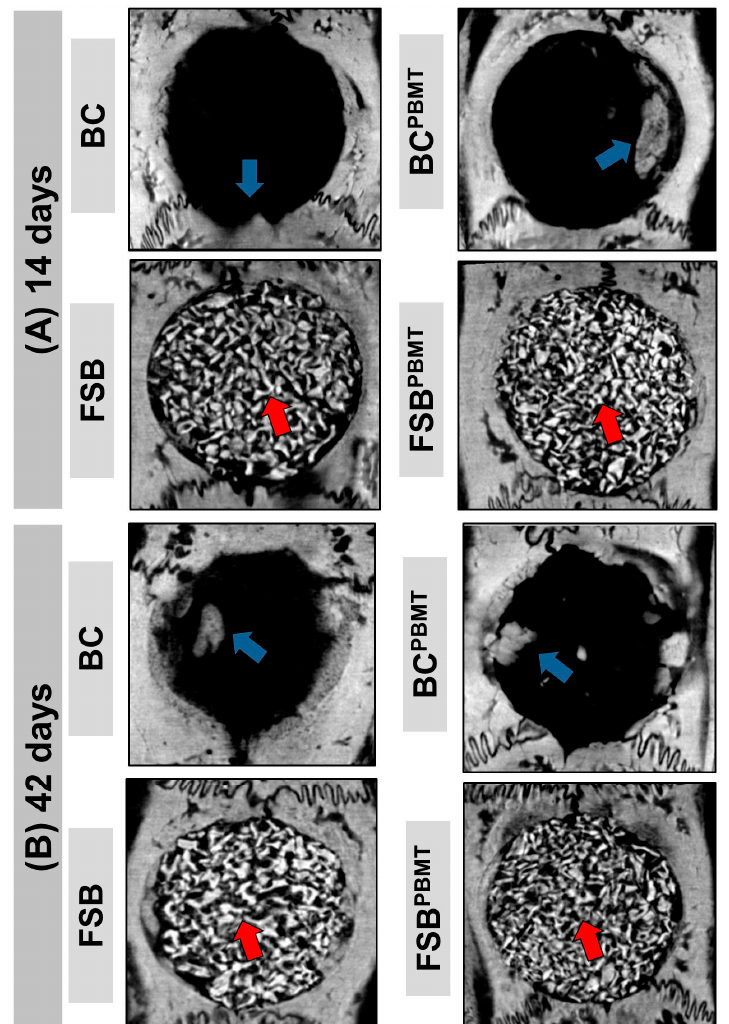
Figure 1. Microtomographic images showing the evolution of the repair of defects filled with clot and fibrin sealant plus xenograft (biomaterial) with or without low-level laser biostimulation therapy. Biomaterial particles (red arrow) and newly formed bone tissue (blue arrow). Two-dimensional trans-axial cuts at ( A ) 14 days; and ( B ) 42 days, respectively.